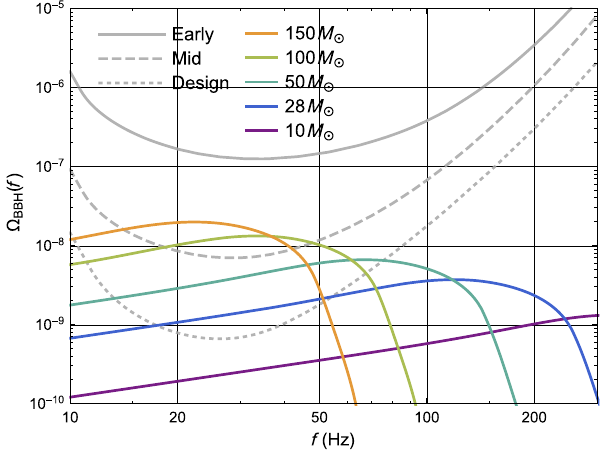
FIG. 1. Binary black hole backgrounds of various chirp masses, assuming a local coalescence rate of R 0 ¼ 16 Gpc − 3 yr − 1 and the Fiducial model for the stochastic background. Power-law integrated curves [25] for one year of integration with Advanced LIGO at early, middle, and design sensitivity are shown for comparison. Approximately 95% of the signal-to-noise ratio comes from a band spanning 15 – 45 Hz. The shape and amplitude f Þ depend on the average chirp mass of the BBH of Ω BBH ð population. As M c increases with fixed R 0 , the peak value of Ω f Þ grows like M 5 = 3 c , while the knee frequency f at BBH ð max ∼ 1 = M which the peak occurs scales as f c max